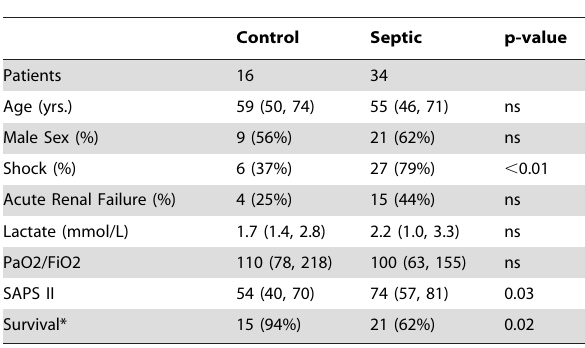
Table 1. Demographics Patient